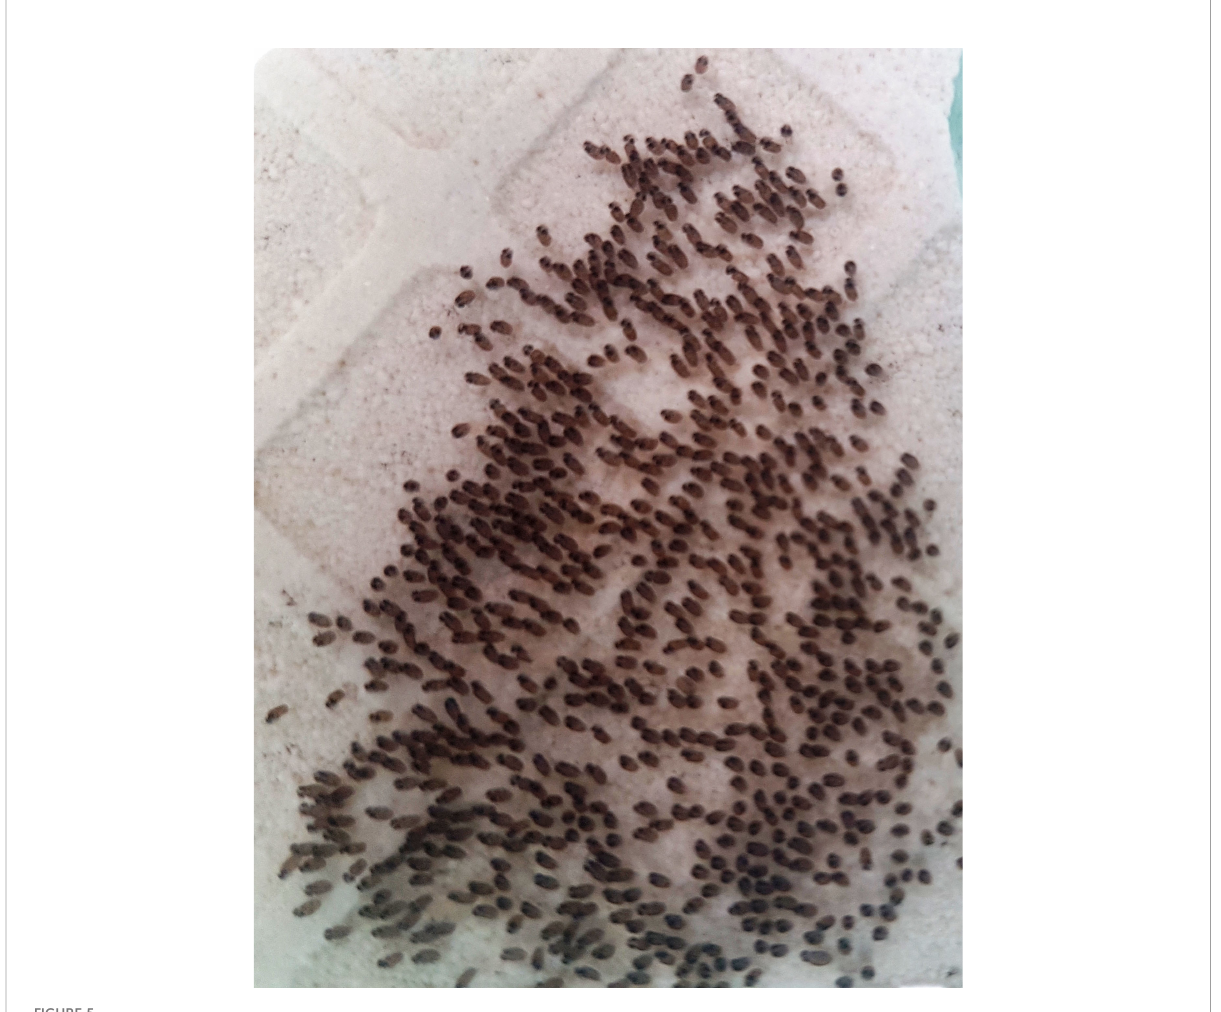
FIGURE 5 Eggs of designer clown fi sh on eighth